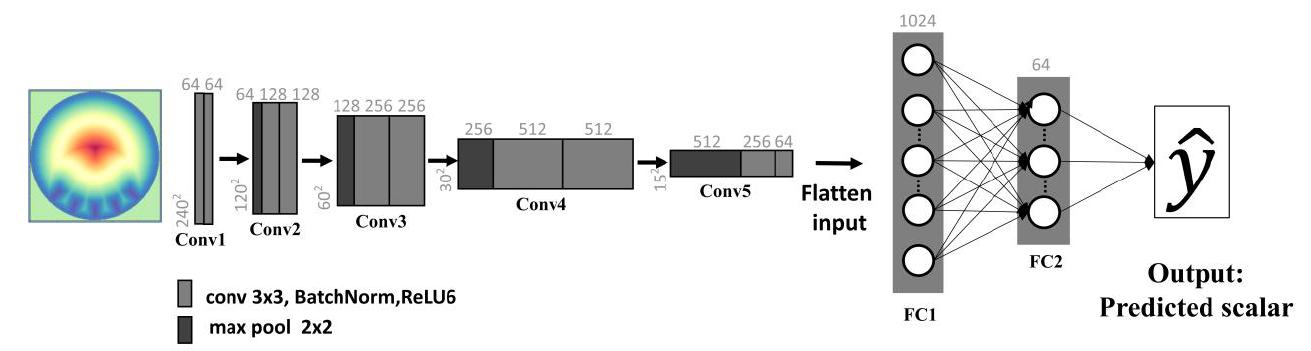
Figure 7. The detailed structure of the proposed deep CNN-based ROM for scalar prediction.